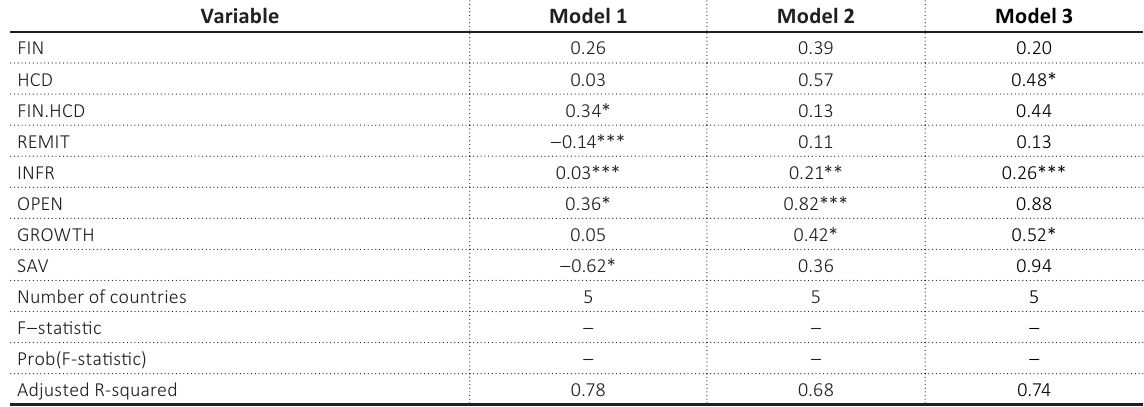
Table 7. Financial sector development and FDI inflows –